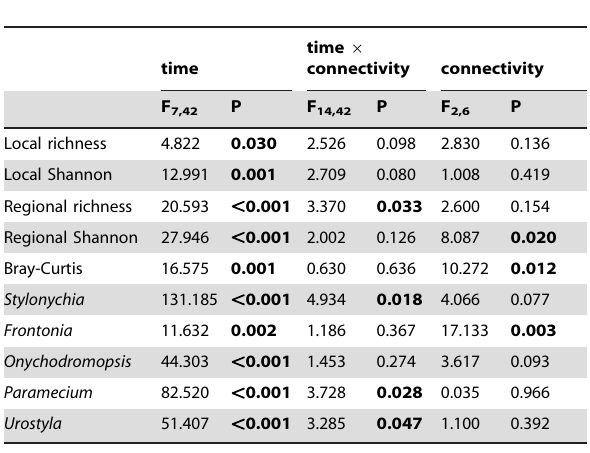
Table 1. Results of one-way rm-ANOVAs testing for effects of time and connectivity on measures of local and regional diversity, on beta diversity expressed as Bray-Curtis distance, and on mean local abundances of the five ciliate